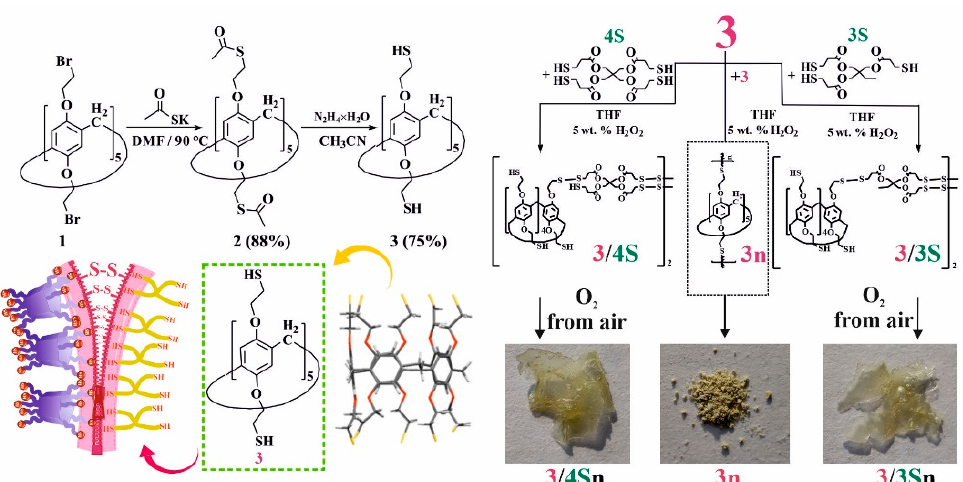
Figure 1. Synthesis of macrocycles 2 and 3 ; X-ray lateral view of macrocycle 3 and sketch showing copolymerization of macrocycle 3 into 3n and 3 with trimethylolpropane-tris(3-mercaptopropionate) 3S and pentaerythritol-tetrakis(3-mercaptopropionate) 4S in THF in the presence of 5 wt. % H 2 O 2 and atmospheric oxygen.